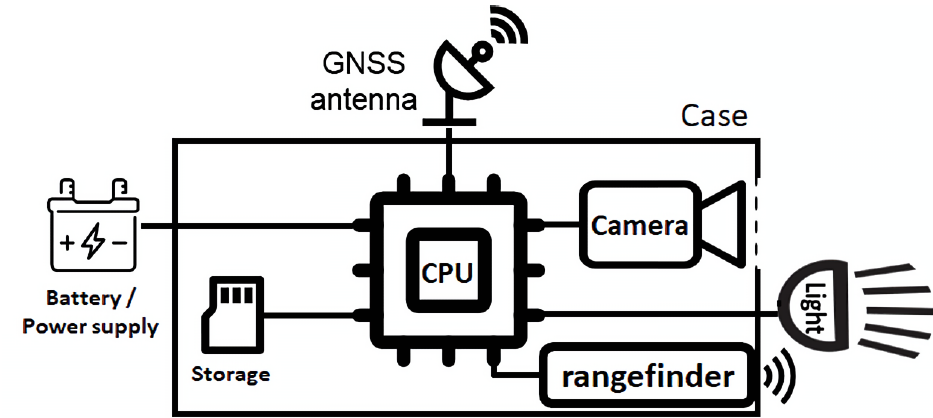
Figure 1. Simplified schematic representation of the acquisition